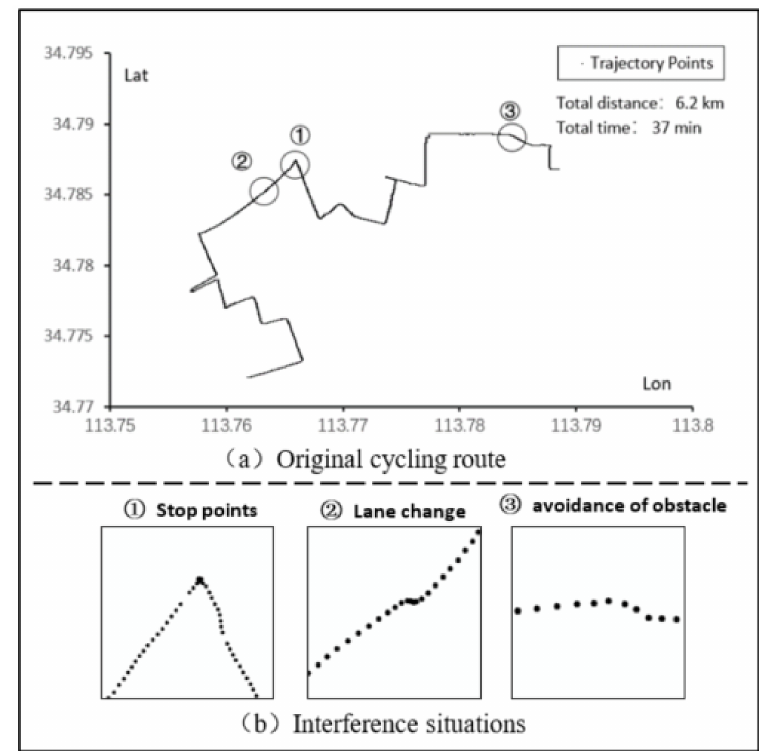
Figure 9. The first example of cycling trajectory.